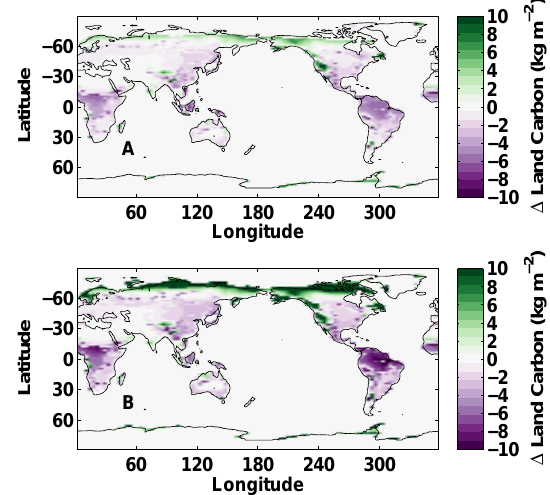
Figure 10. Changes in land carbon for the 5275GtC FAST sce- nario. (a) Minimum (year-2310) minus peak (year-2170) total land carbon, and (b) year-2990 minus minumum (year-2310) total land